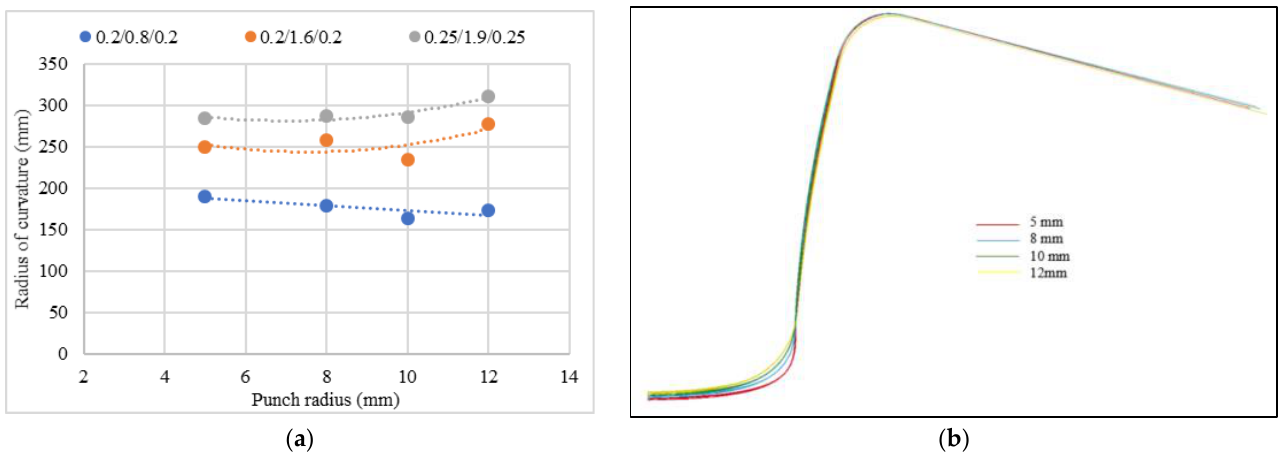
Figure 14. ( a ) Effect of punch radius on radius of curvature for three different sandwich laminate thickness combinations and constant die radius of 8 mm, and ( b ) Springback profiles of 0.2/1.6/0.2 mm sandwich laminates with different punch radii and a constant die radius of 8 mm.